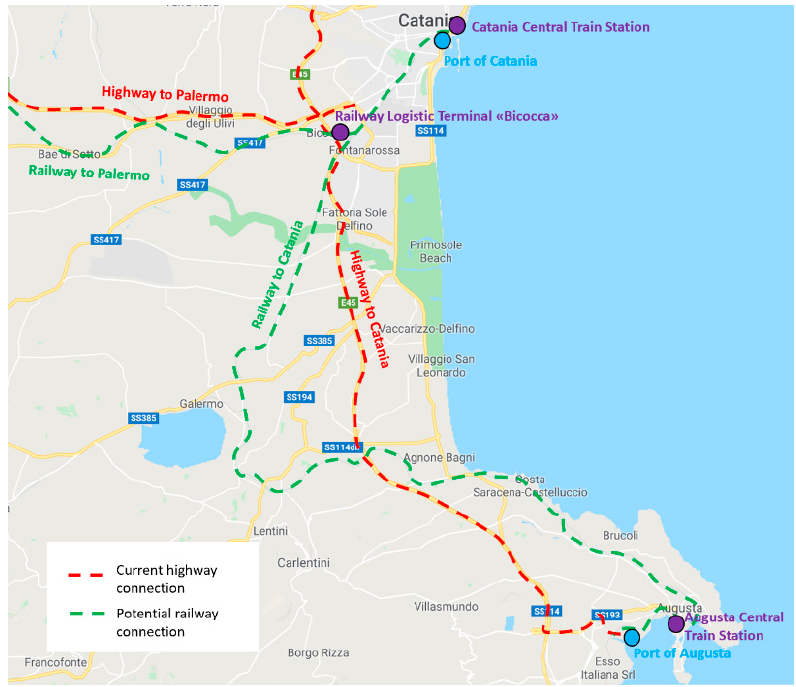
Figure 5. Hinterland connection opportunities.